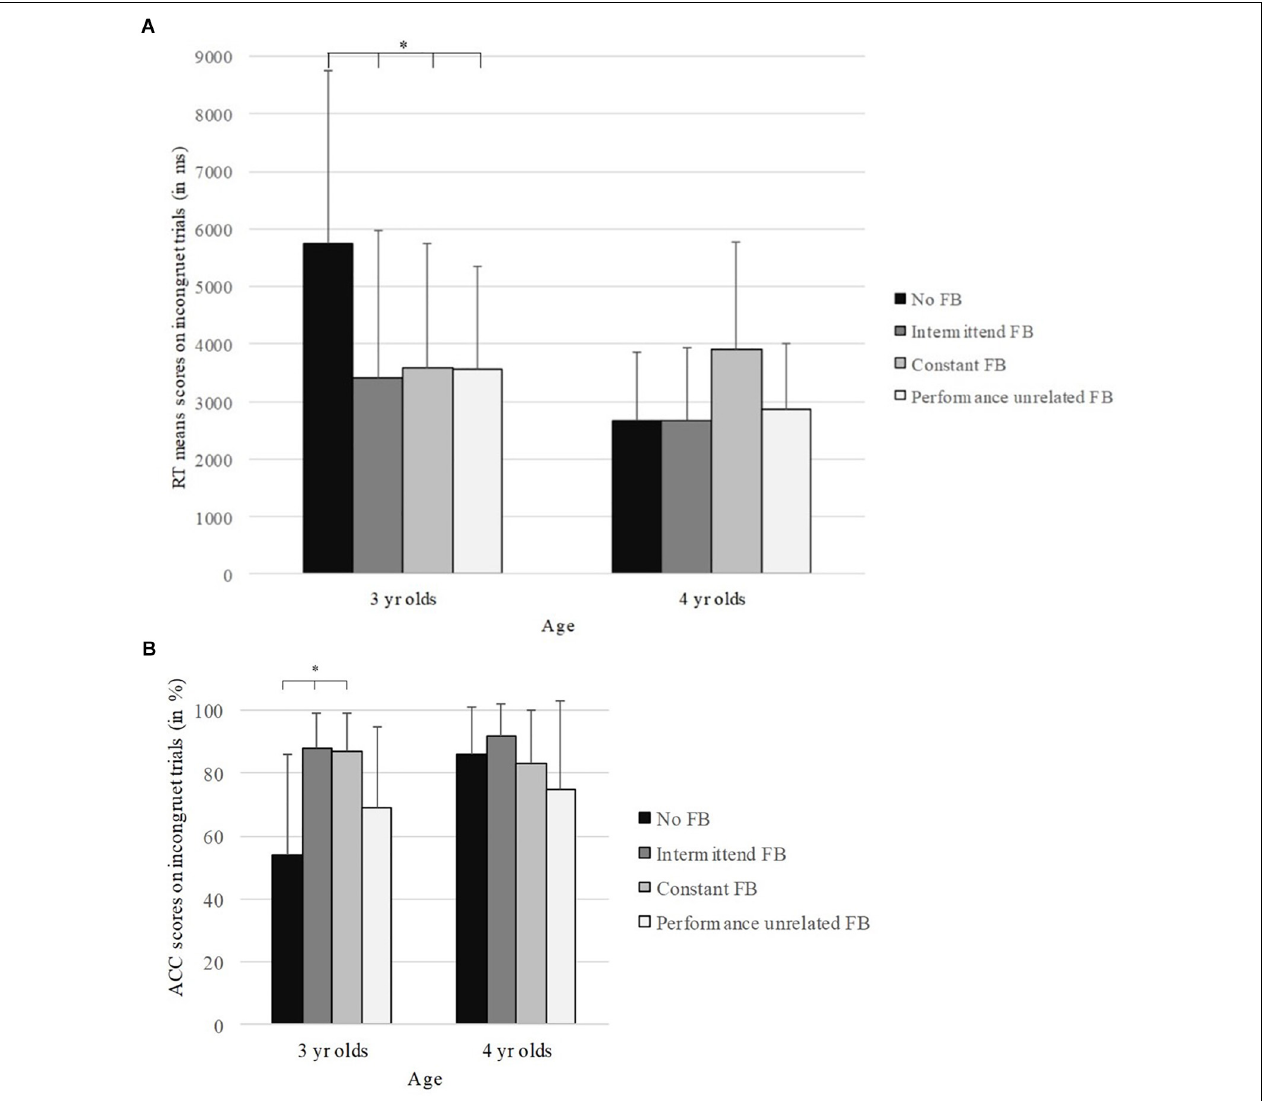
FIGURE 1 | Flanker task means as a function of age group and condition, in terms of accuracy (A) and reaction time (RT) (B) . Significant differences between the no-feedback condition and the other feedback conditions are indicated with a ∗